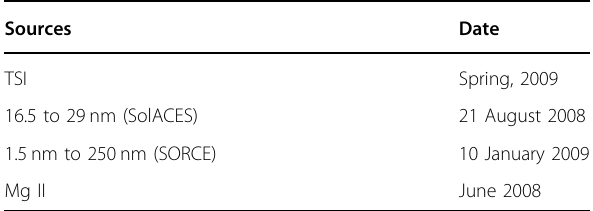
Table 6 Date of minima provided by the data used in this